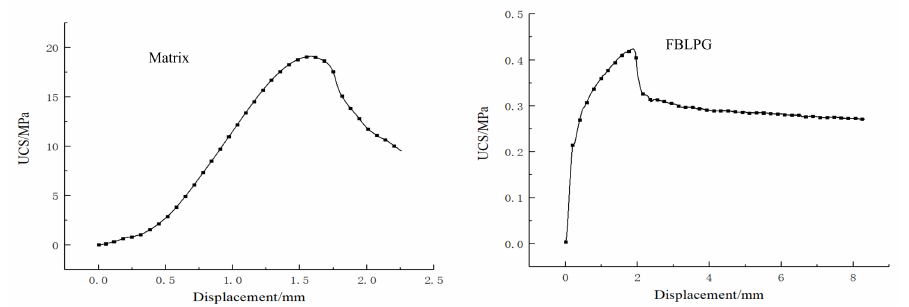
Figure 6. Typical stress–displacement curve of FBLPG (UCS, uniaxial compression